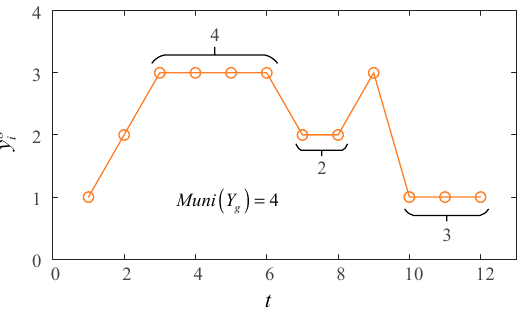
(cid:0) (cid:1) ( ) Y g Muni Y . Figure 3. Illustration of Muni g